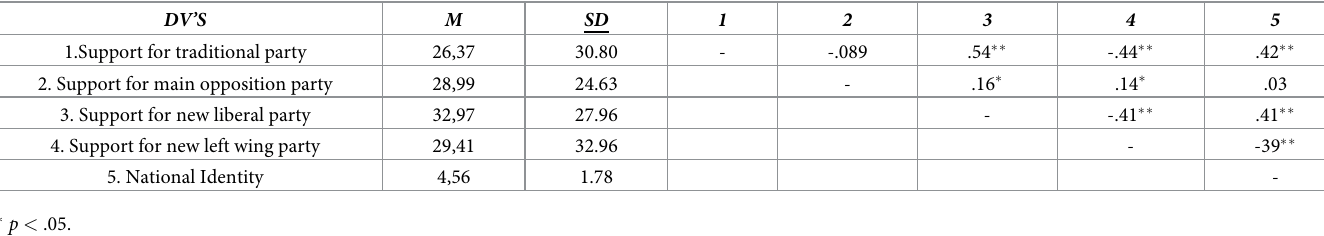
Table 2. Mean, standard deviations and correlations for support to the parties and national identity.